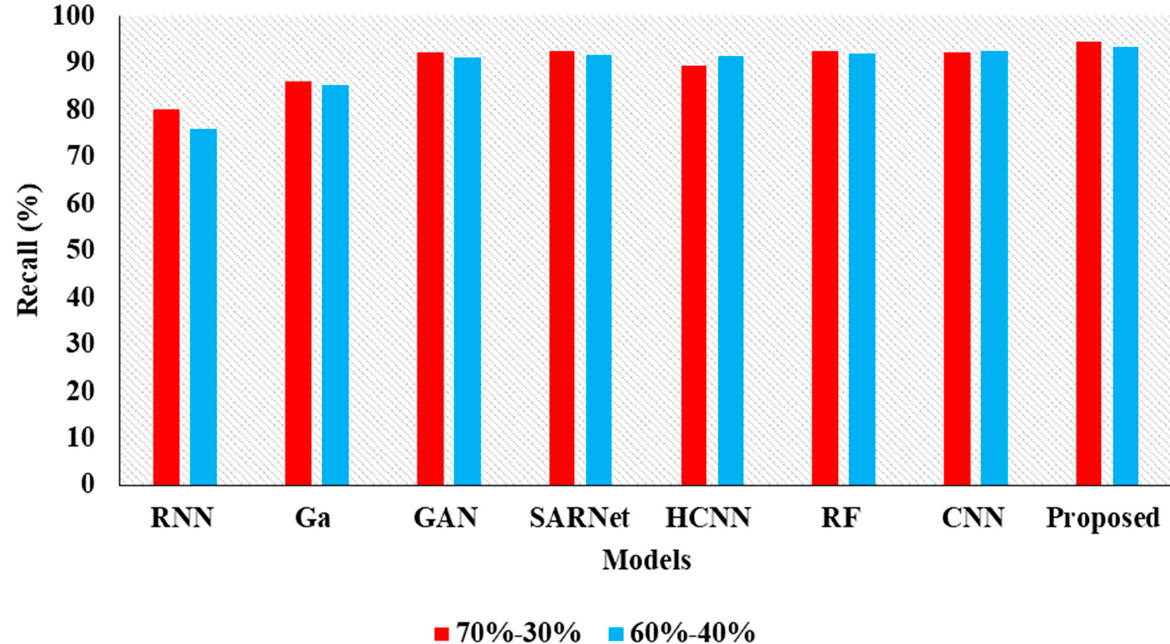
Figure 7. Recall Comparison for two data splits-ups.